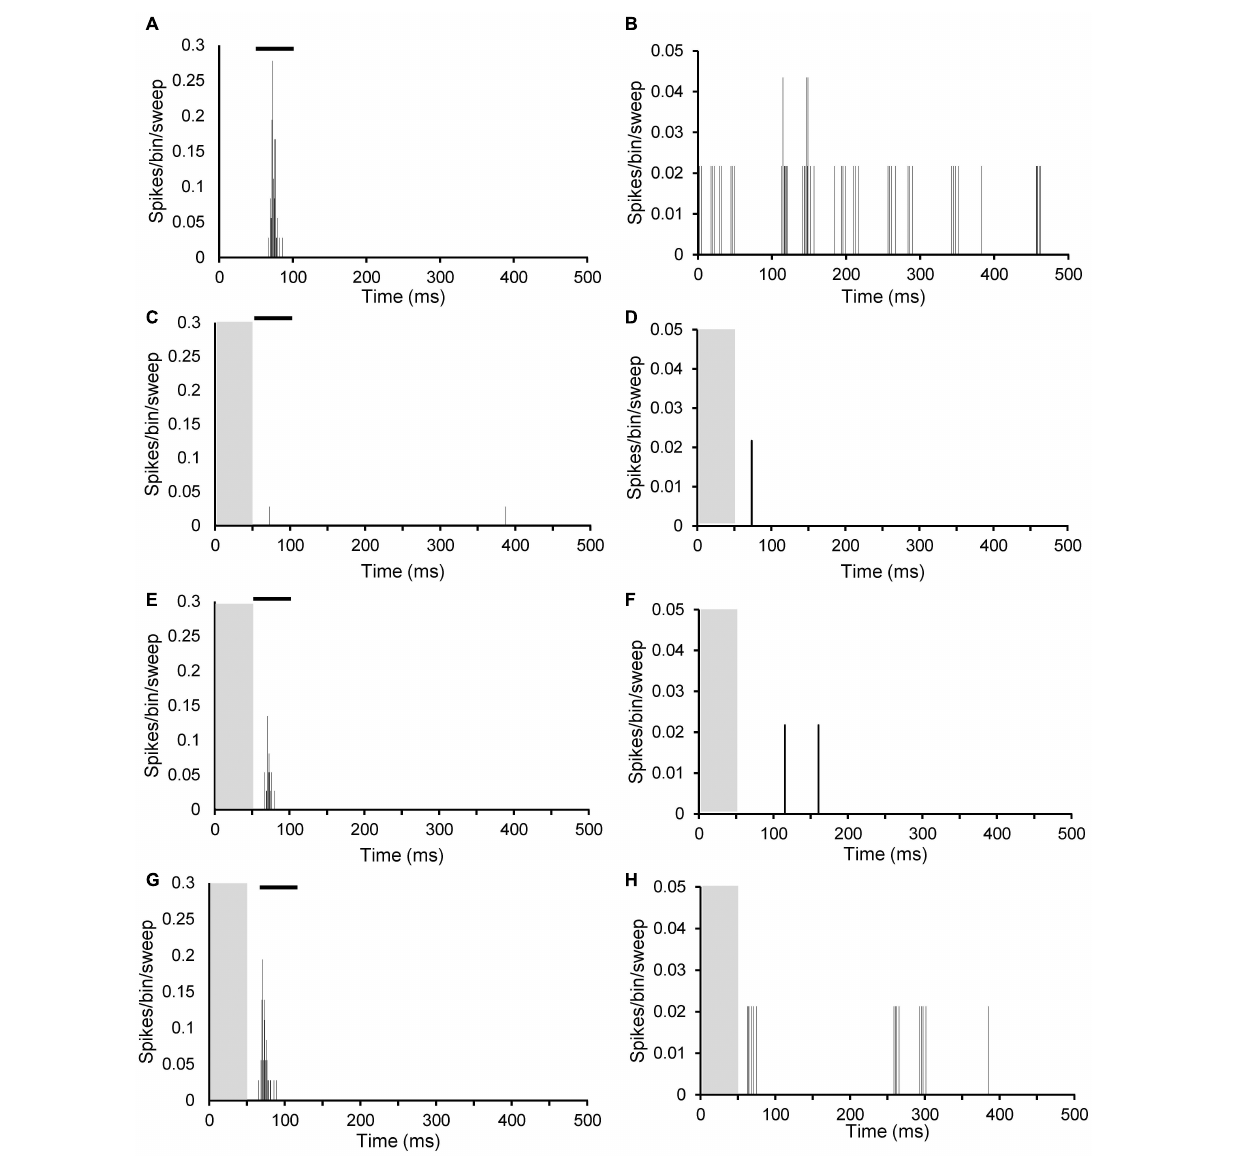
FIGURE 5 | Peristimulus time histograms (PSTHs) illustrating inhibitory effects of PFC electrical stimulation at different stimulation strengths on sound evoked response at CF 20 dB above threshold (left column; A,C,E,G ) and on spontaneous firing (right column; B,D,F,H ). (A,B) No stimulation; (C,D) 1 mA; (E,F) 0.7 mA; and (G,H) 0.4 mA. Both neurons from an AT animal. Neuron left column CF 2.5 kHz with threshold 74 dB SPL and SFR 0.1 spikes/sec. Neuron right column CF 1.9 kHz with threshold 86 dB SPL and SFR 2.1 spikes/sec. Grey column indicates electrical stimulation and black bar in (A,C,E,G) illustrates timing of tone